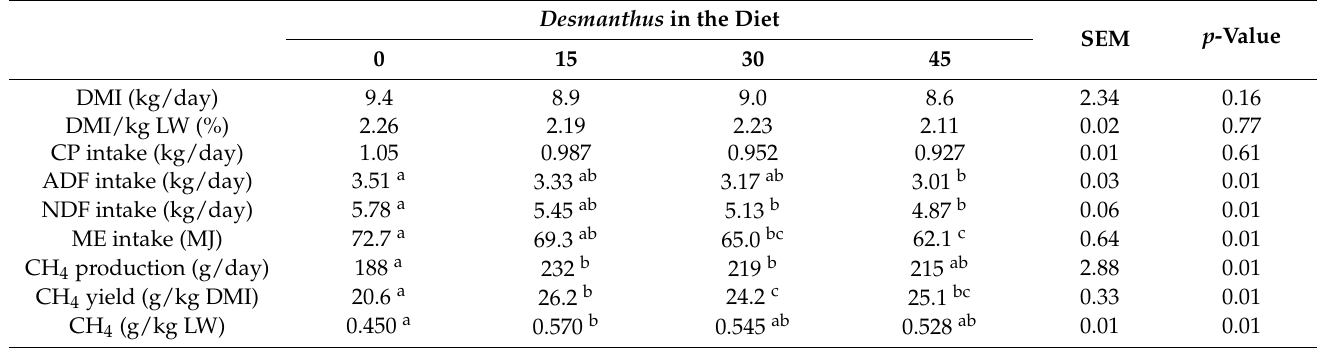
Table 5. Effect of level of inclusion of Desmanthus cultivars on intake, methane production and yield. Desmanthus in the Diet